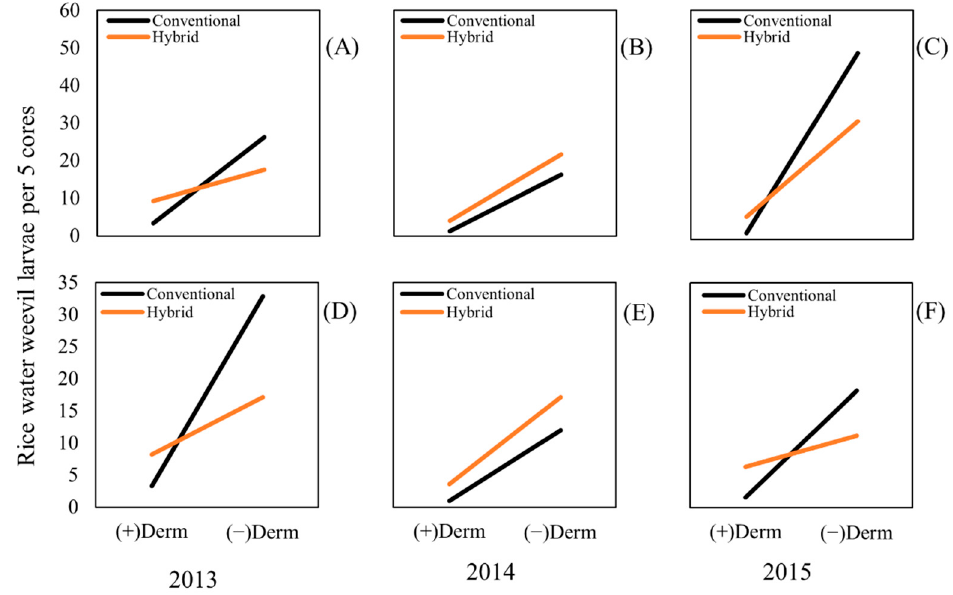
Figure A1. Interactive effects of Dermacor treatment and variety on L. oryzophilus larval densities in 2013, 2014, and 2015. Core 1 ( A , B, and C ) and Core 2 ( D , E, and F ) sampling were performed three and four weeks after permanent flooding. Parallel lines indicate absence of interaction ( P > 0.05), while lines with different slopes (non-parallel lines) indicate presence of interaction ( P < 0.05). Figure A,C,D,F show significant